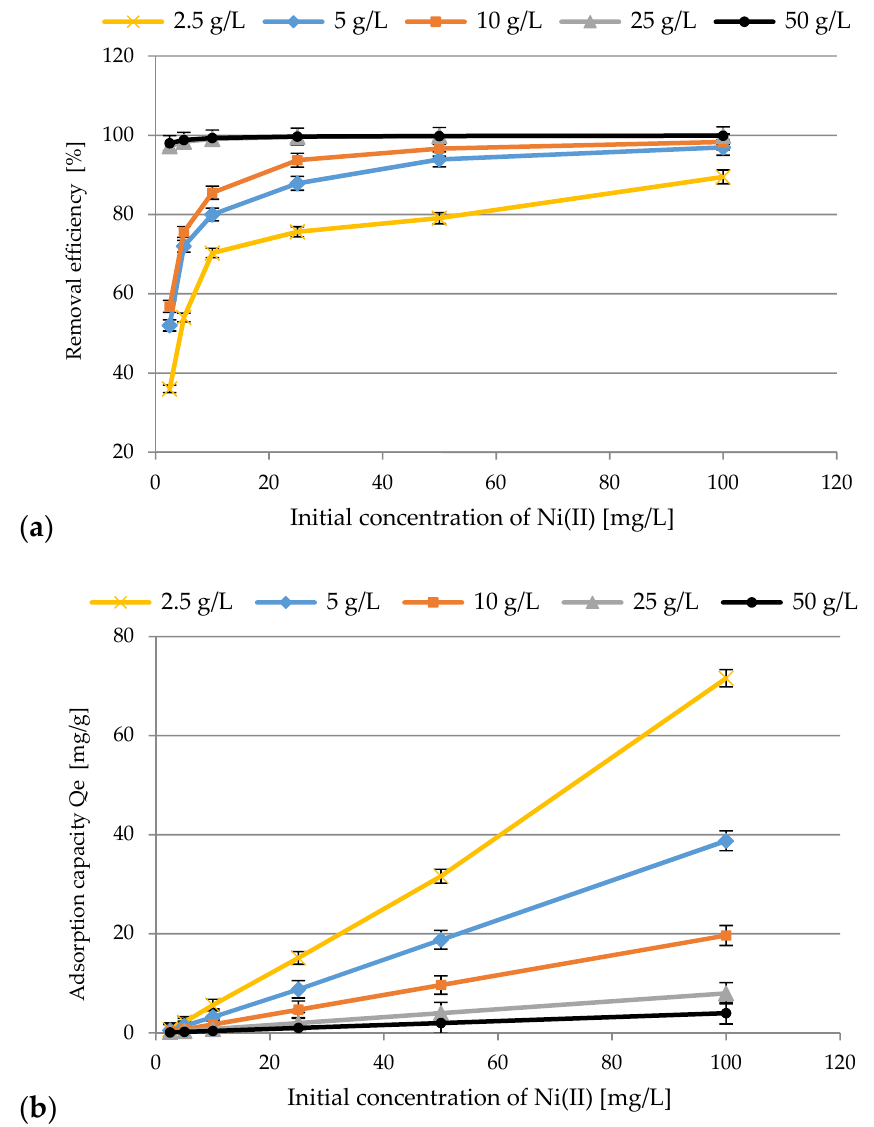
Figure 9. The effect of initial concentration of Ni(II) ions on SS-FA removal efficiency ( a ) and adsorption capacity ( b ).